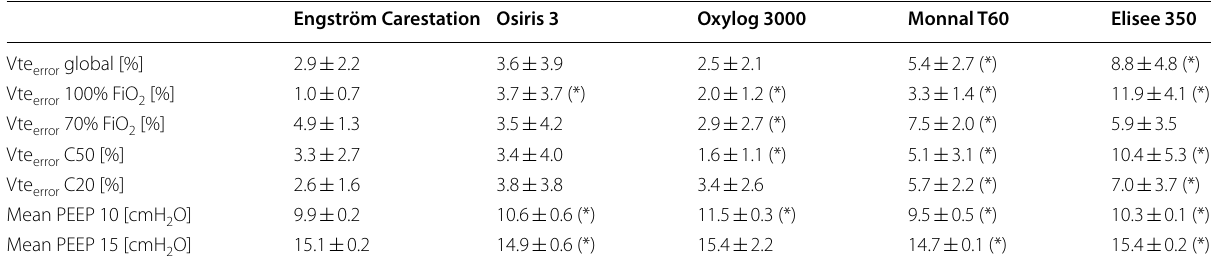
Table 2 Mean volume errors and Positive End Expiratory Pressure 1 (PEEP) measured for each ventilator